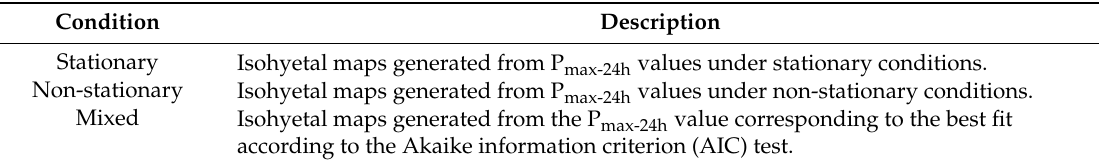
Table 3. Types of isohyetal